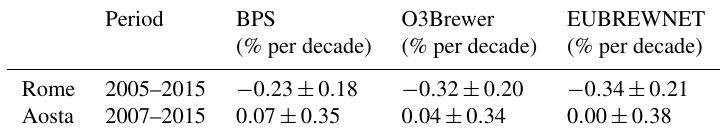
Table 6. The total ozone linear trends derived by the processed ozone values using three different processing codes. Period BPS O3Brewer EUBREWNET (% per decade) (% per decade)